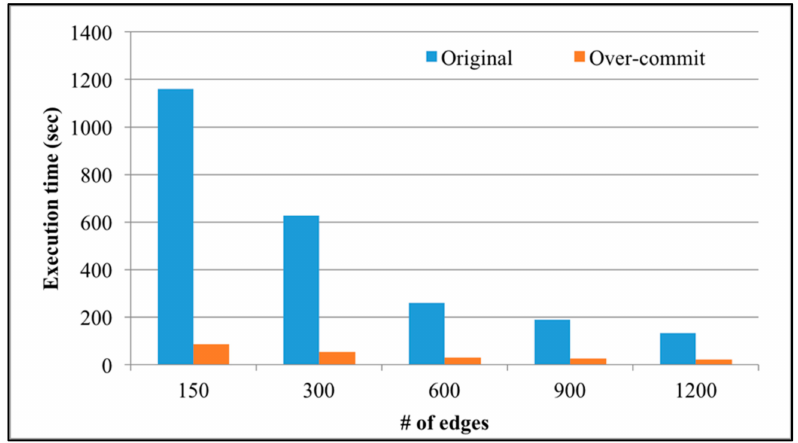
Figure 11. Execution time of executing SparkTC without over-committed resources and with 64 over-committed